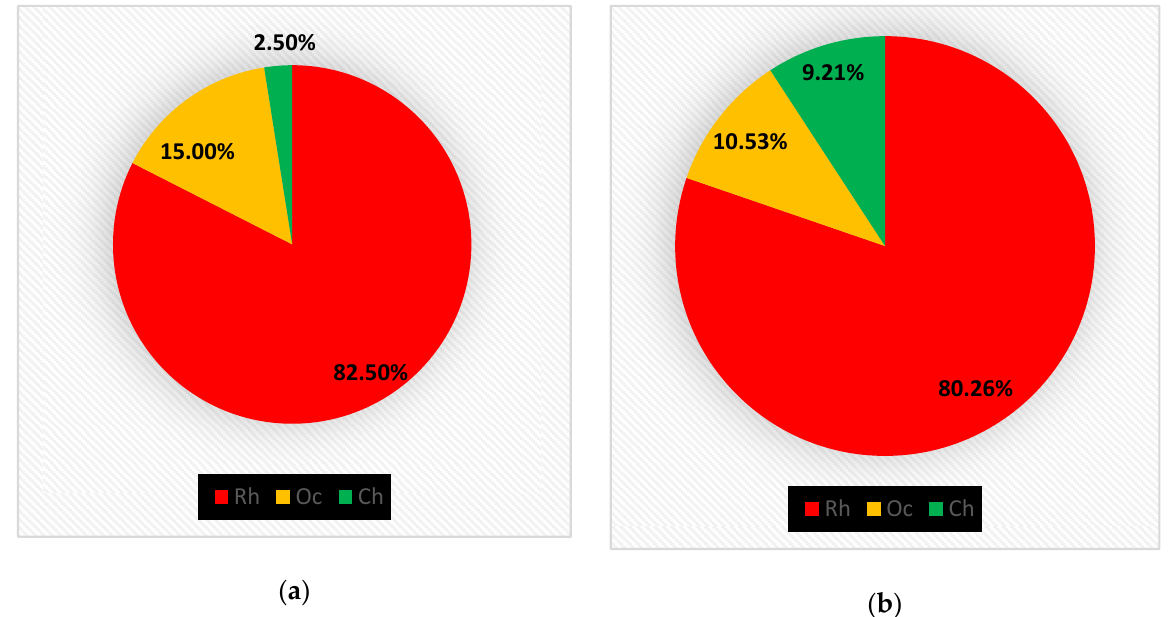
Figure 3. ( a ) Percent incidence of Rhodophyta (Rh), Ochrophyta (Oc), and Chlorophyta (Ch) of the flora studied in the 1970s [16,17]; ( b ) Percent incidence of Rhodophyta (Rh), Ochrophyta (Oc), and Chlorophyta (Ch) of the flora studied in 2001 [18].